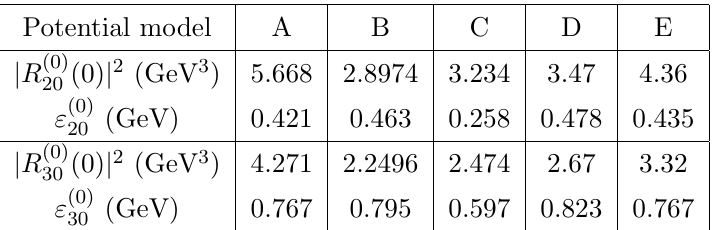
Table 3 . For the (cid:12)ve potential models described in the text, we list the squared radial wavefunctions at the origin, j R (0) (0) j 2 , and the binding energies, " (0) n 0